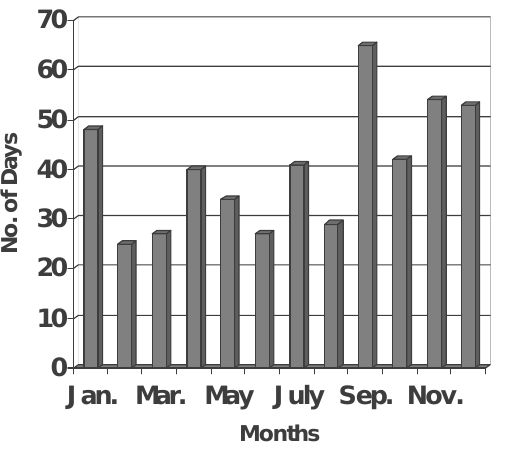
Fig. 1. A histogram representing days of data collection spread over a period of 8 years (1995–2003).